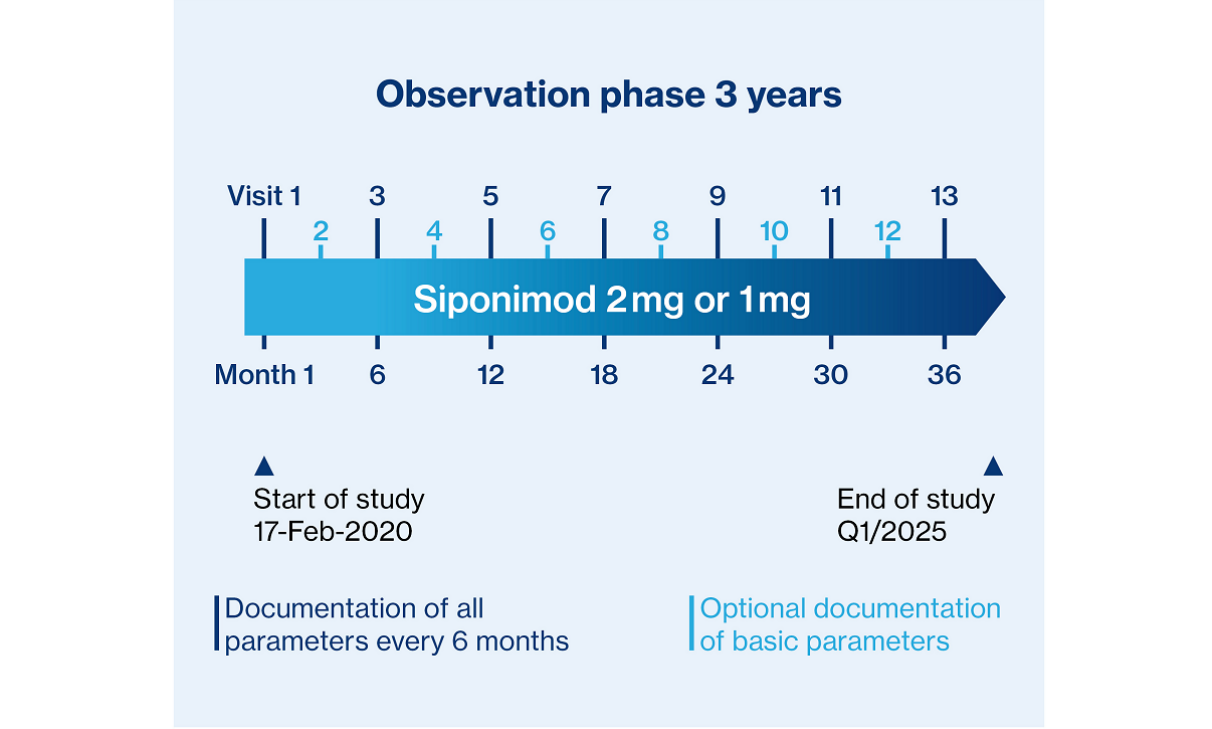
Figure 2. Study design of AMASIA (imp A ct of M ayzent [siponimod] on second A ry progressive multiple S clerosis patients in a long-term non- I nterventional study in Germ A ny), a non-interventional study involving an initial dose titration (visit 1), followed by a 3-year observational phase (visits